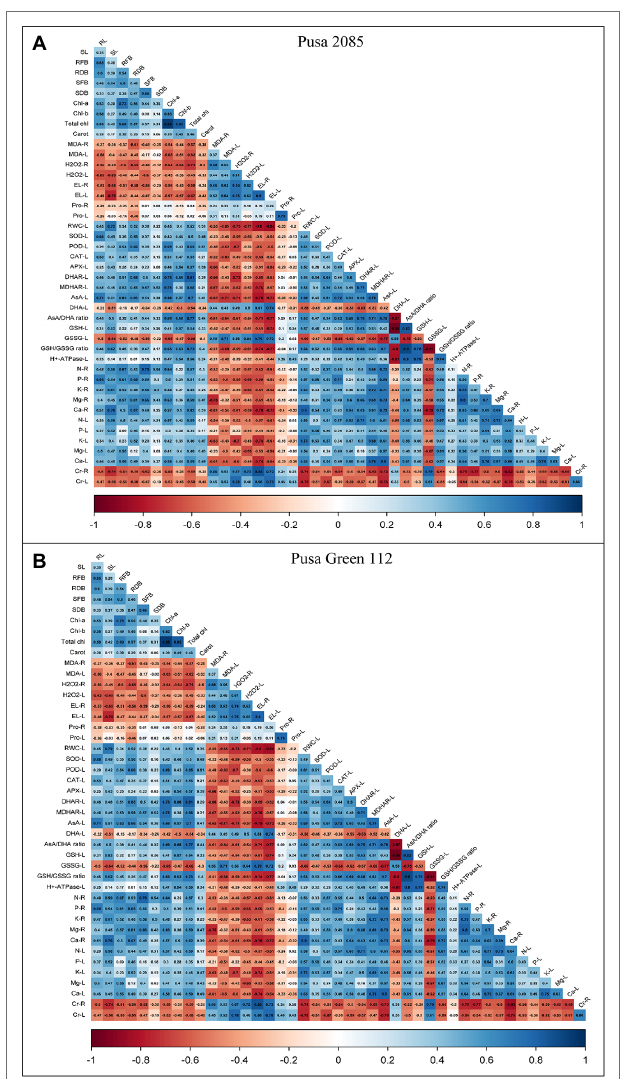
FIGURE 8 | Correlation between growth, physiological and biochemical parameters, NaHS, Si alone or in the interactive treatment of NaHS + Si with Cr uptake in different parts of both chickpea varieties (A) Pusa 2085 and (B) Pusa Green 112. RL, Root length; SL, Shoot length; RFB, Root fresh biomass; SFB, Shoot fresh biomass; RDB, Root dry biomass; SDB, Shoot dry biomass; Chl- a , Chlorophyll- a ; Chl- b , Chlorophyll- b ; Carot, Total chlorophyll, Carotenoid contents; RWC, relative water contents; H 2 O 2 -R, H 2 O 2 level in roots; H 2 O 2 -L, H 2 O 2 level in leaves; MDA-R, MDA level in roots; MDA-L, MDA level in leaves; EL-R, Electrolyte leakage in roots; EL-L, Electrolyte leakage in leaves; Pro-R, Proline level in roots; Pro-L, Proline level in leaves; SOD-L, SOD enzyme in leaves; POD-L, POD enzyme in leaves; CAT-L, CAT enzyme in leaves; APX-L, APX enzyme in leaves; DHAR-L, DHAR enzyme in leaves; MDHAR-L, MDHAR enzyme in leaves; AsA-L, AsA level in leaves; DHA-L, DHA level in leaves; GSH-L, GSH level in leaves; GSSG-L, GSSG level in leaves; AsA/DHA ratio, AsA/DHA level in leaves; GSH/GSSG ratio, GHS/GSSG level in leaves; H + -ATPase-L, H + -ATPase activity in leaves; N-R, Nitrogen content in roots; N-L, Nitrogen content in leaves; P-L, Phosphorus content in leaves; P-R, Phosphorus content in roots; K-R, Potassium content in roots; K-L, Potassium content in leaves; Ca-R, Calcium content in roots; Ca-L, Calcium content in leaves; Mg-R, Magnesium content in roots; Mg-L, Magnesium content in leaves; Cr-R, Chromium contents in roots; and Cr-L, Chromium contents in